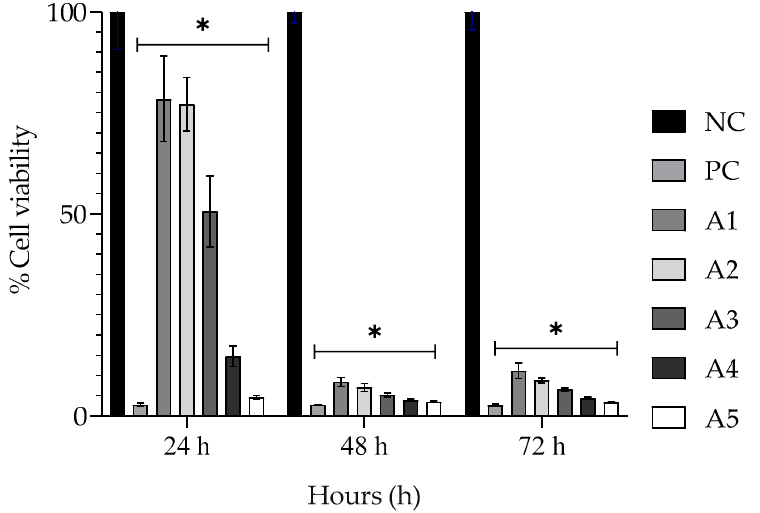
Figure 3. Mean ± SD of the percentage cell viability of the negative control (NC; physiologic solution 0.9%), positive control (PC; 2% Tween 80%), and acetic acid evaluated at five different concentrations (A1—0.015%, A2—0.030%, A3—0.060%, A4—0.120%, and A5—0.240%) by the MTT method. One-way ANOVA followed by Tukey’s post hoc test. The asterisk (*) indicates a significant difference ( p < 0.05) between groups.